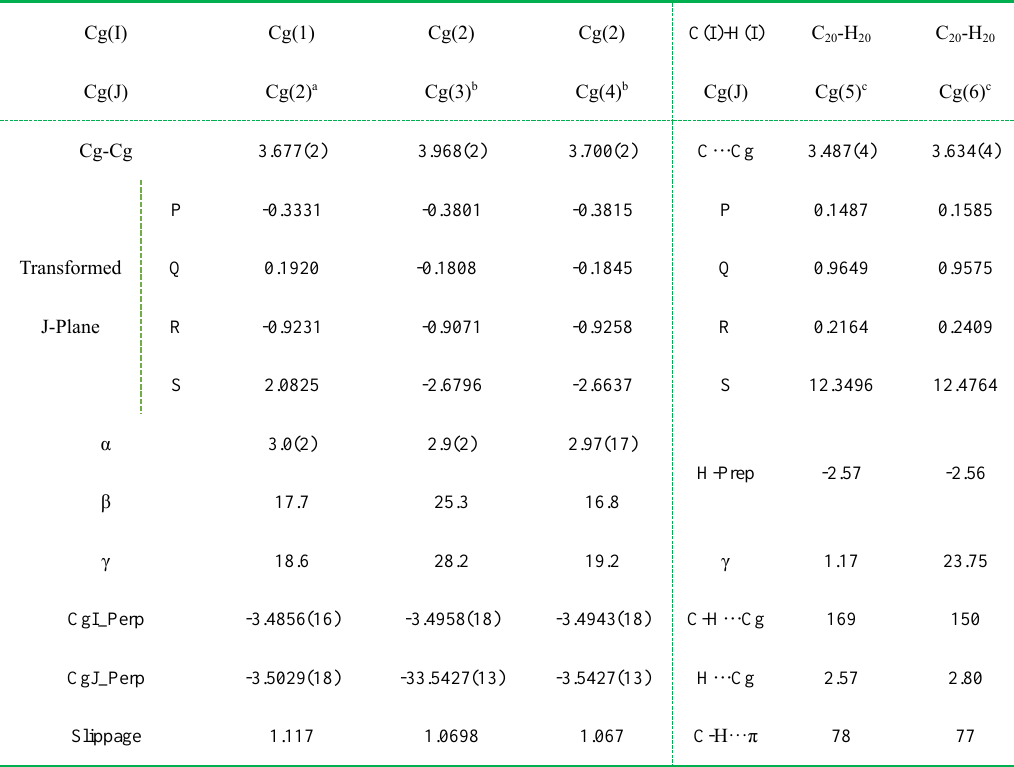
Table SI Short Ring/[C–H∙∙∙ Cg (π-ring)] Interactions. [ Cg – Cg/ (H∙∙∙ Cg ) Distances in